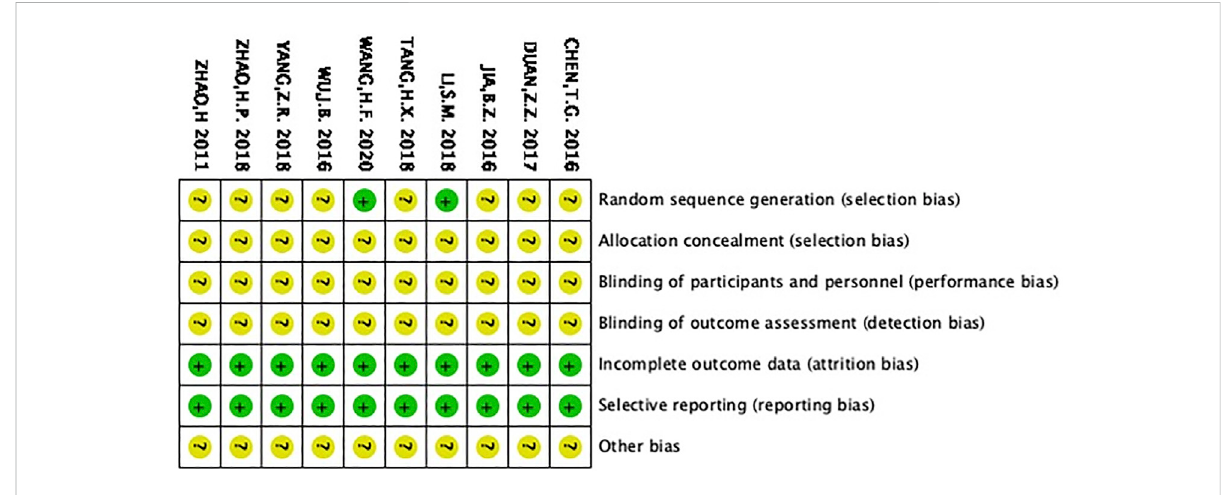
FIGURE 3 Graph showing the risk of selection bias. (+) low risk, (?) unclear risk.